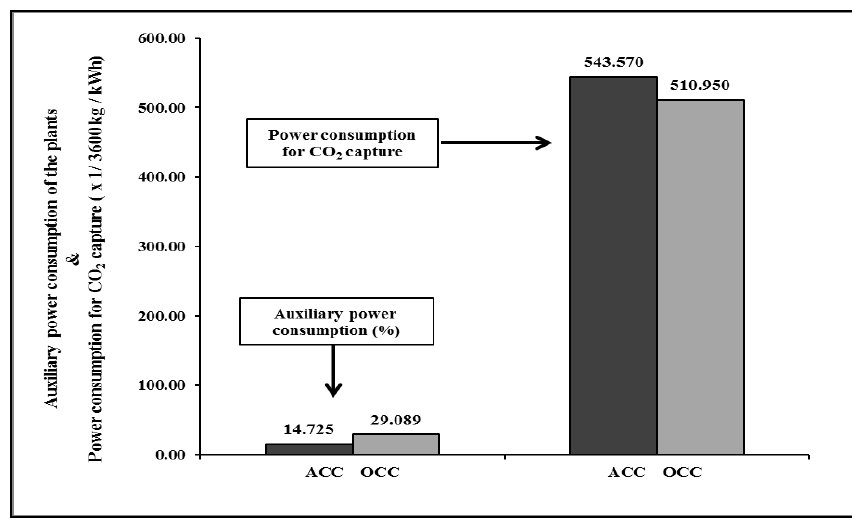
Figure 4. Comparative study on auxiliary power consumption of the